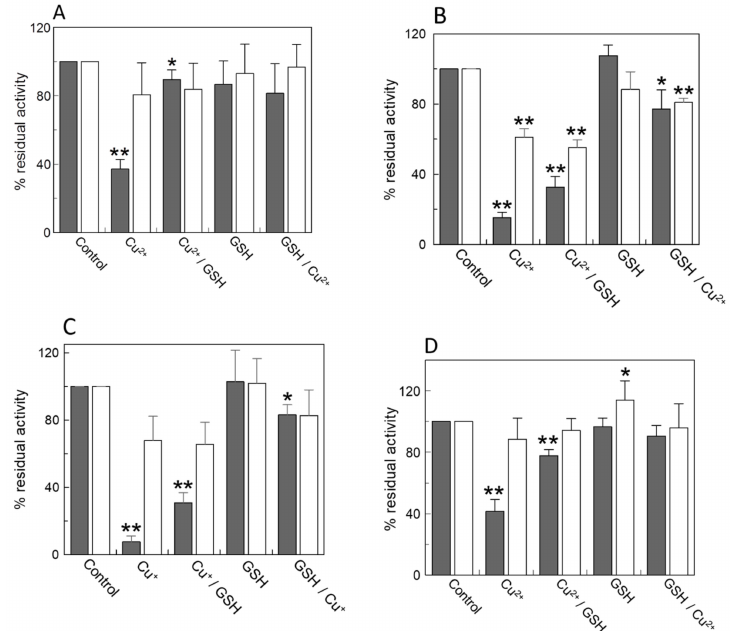
Figure 1. Effectofcopperandreducedglutathione(GSH)onnativeandrecombinantcarnitine / acylcarnitine carrier (CAC). ( A ) Rat liver mitochondria (5 mg / 100 µ L) were incubated or not (control) for 1 h, with CuCl 2 (50 µ M) or GSH (5 mM) as indicated. After washing, mitochondria (0.3 mg) were then solubilized with